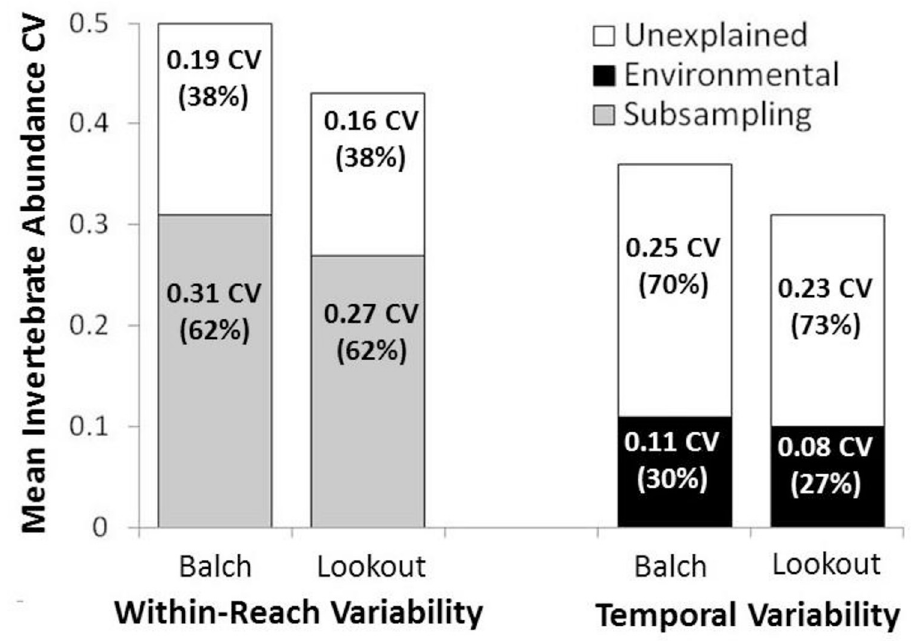
Fig 5. Partitioned invertebrate density CV for both within-reach spatial and long-term temporal citizen-generated data at Balch and Lookout Creeks. Within-reach spatial CV was partitioned into subsampling and unexplained components. Long-term temporal CV was partitioned into environmental (ENSO MEI + Sample-Year) and unexplained components.